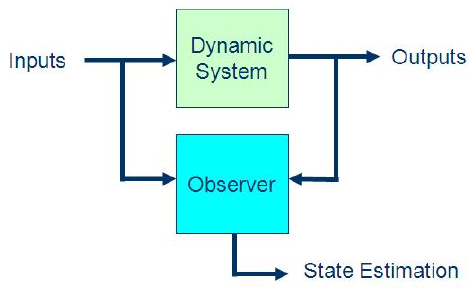
Figure 1. Basic operation of a sliding mode observer.